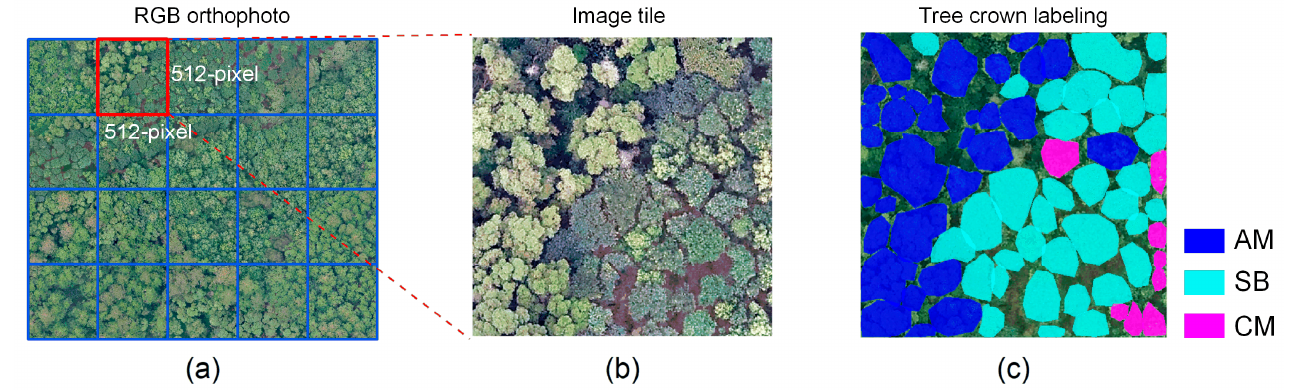
Figure 2. Schematic diagram of sample labeling for individual tree species identification. ( a ) RGB orthophotos. ( b ) 512 × 512-pixel image tile. ( c ) Tree crown labeling results. Table 2. The number of trees labeled in all image tiles of training set and test set for each species. Sample Sets